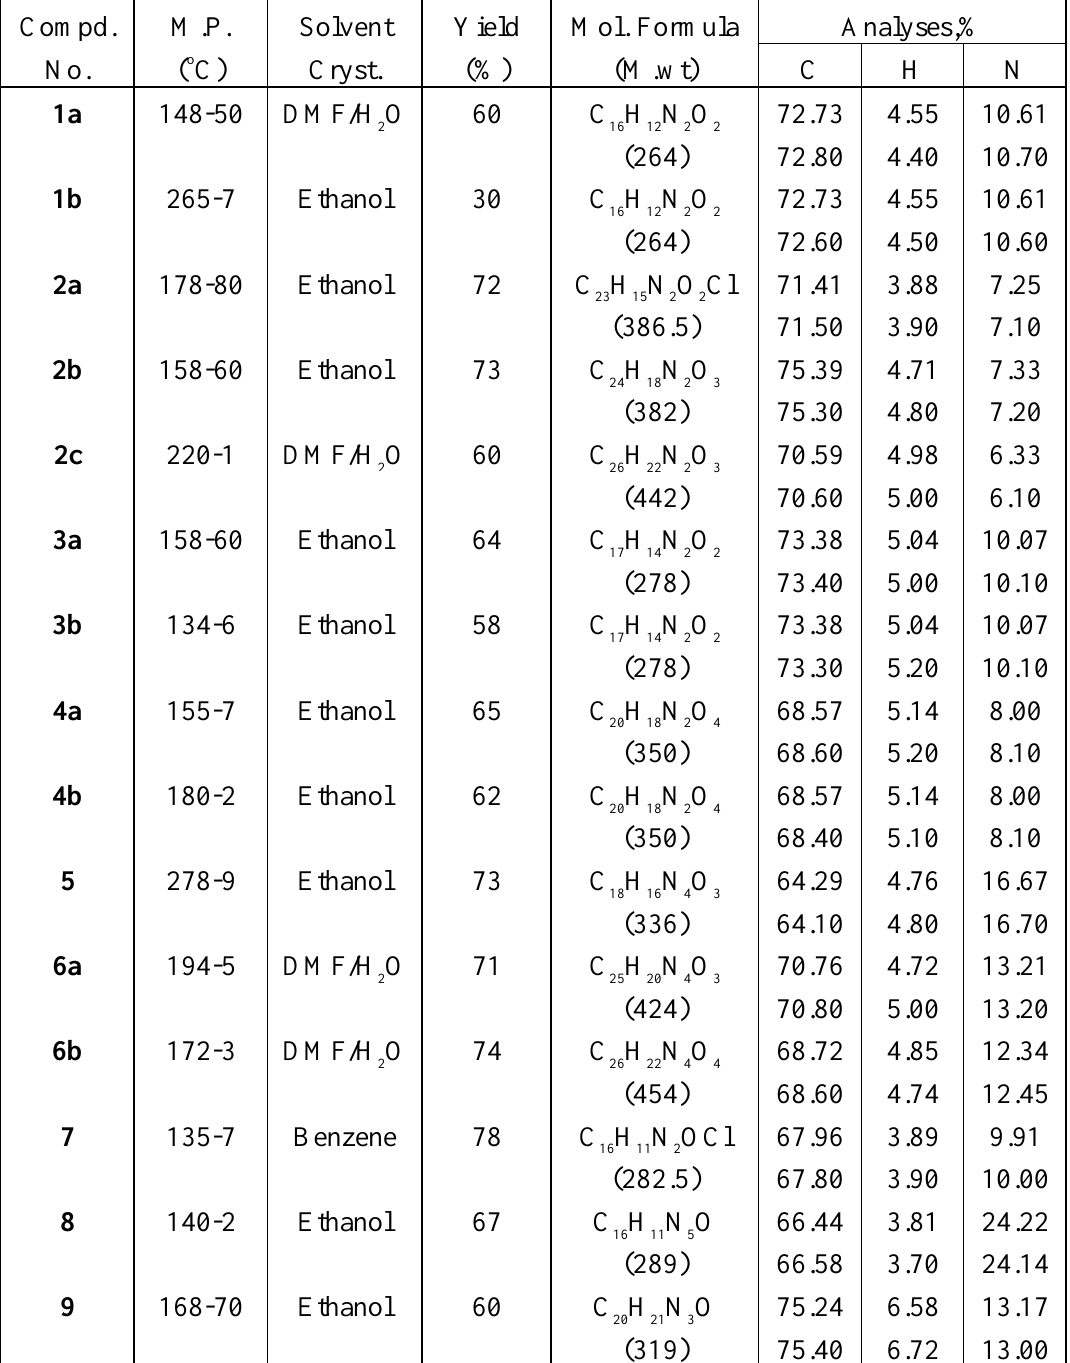
Table 2. Physical data of the compounds